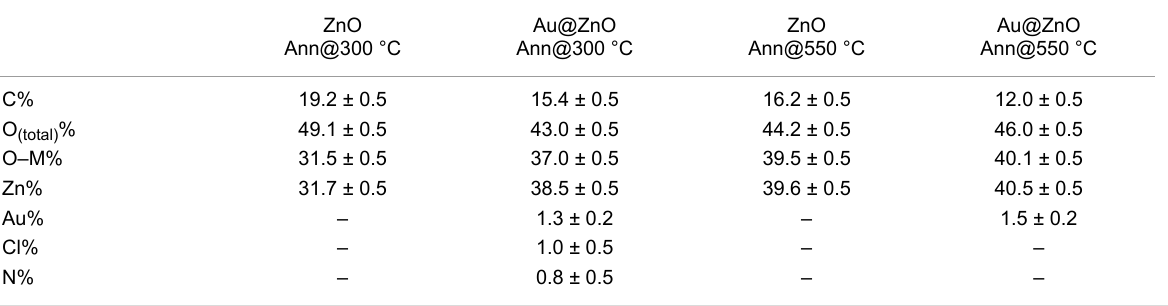
Table 1: XPS surface chemical composition of pristine and Au-functionalized ZnO, annealed at 300 and 550 °C. The O–M percentage refers to the atomic percentage of oxygen bound to metal.